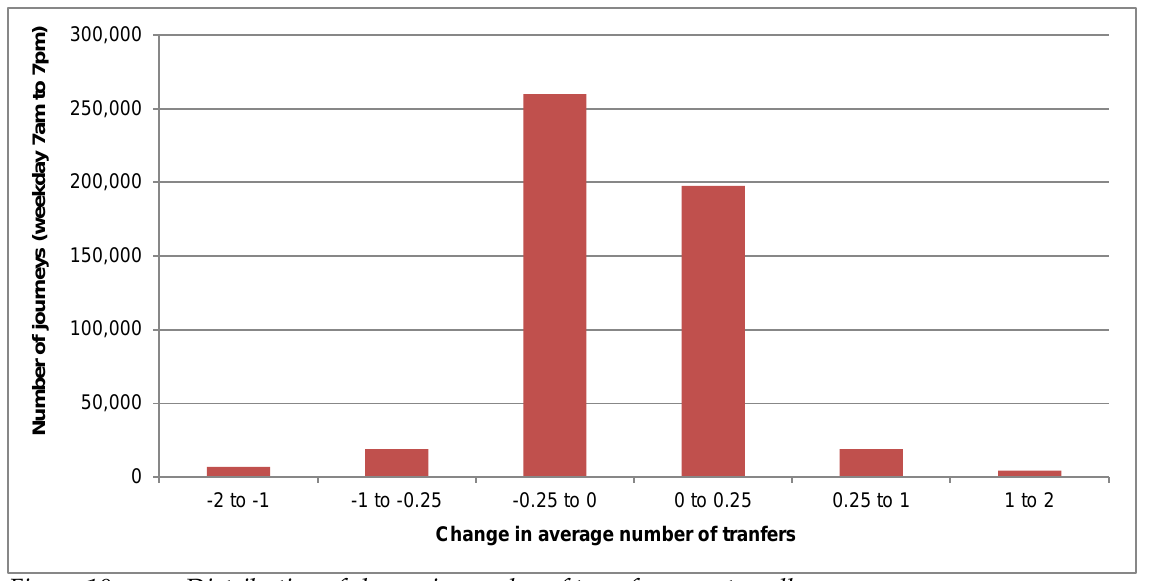
Figure 10. Distribution of change in number of transfers over